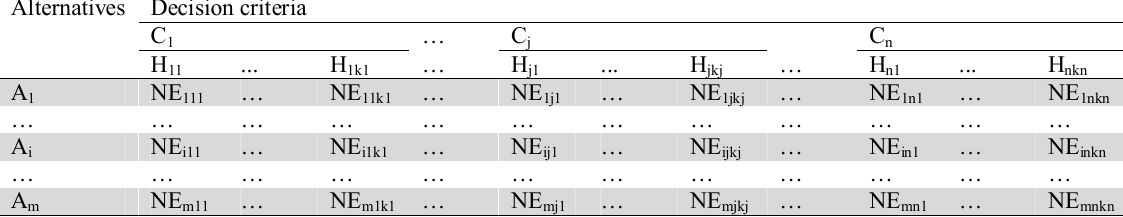
Distribution decision matrix for decision